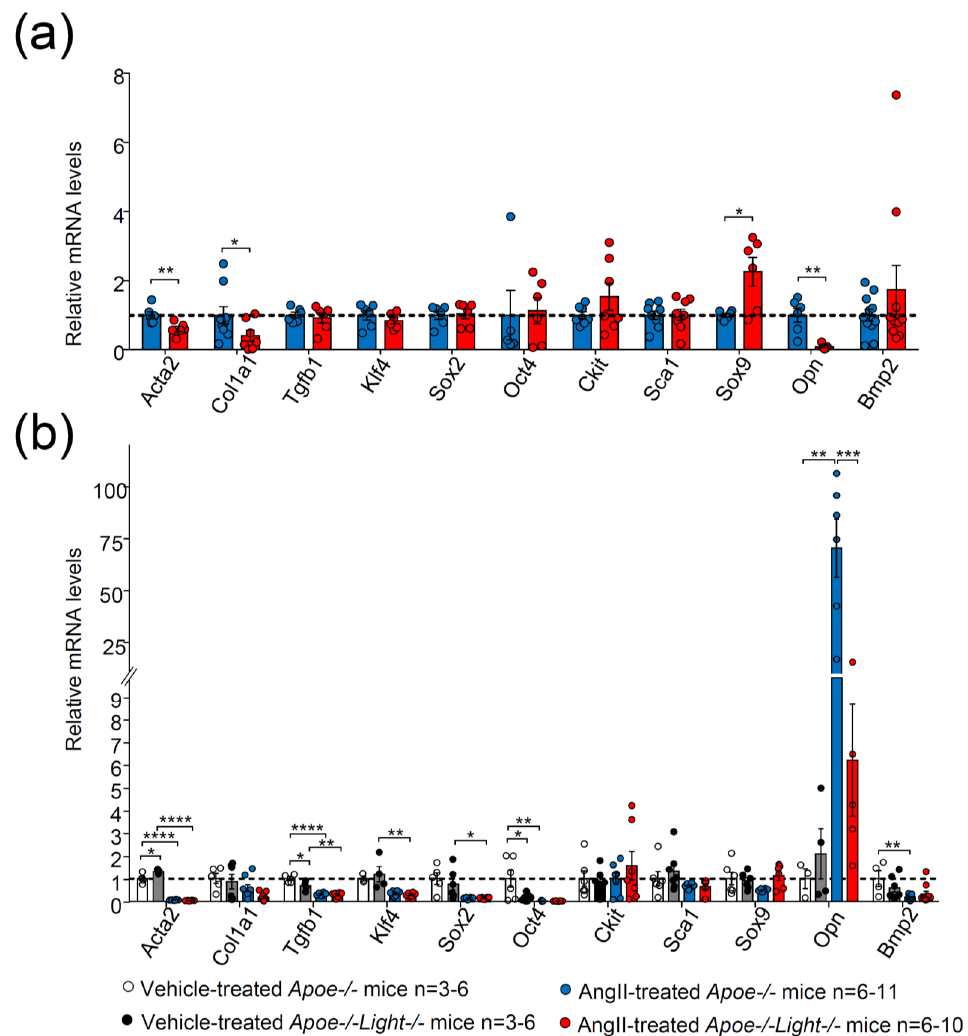
Figure 4. Gene expression analysis in abdominal aortic tissue in vehicle- and AngII–treated Apoe −/− and Apoe −/− Light −/− mice. mRNA levels of Acta2, Col1a1, Tgfb1, Klf4, Sox2, Oct4, Ckit, Sca1, Sox9, Opn , and Bmp2 in ( a ) AngII-treated mice and in ( b ) all four mouse groups. mRNA levels were normalized to Cyclophilin mRNA levels and relativized to ( a ) AngII-treated Apoe −/− mice or to ( b ) vehicle-treated Apoe −/− mice. Statistical analyses were: ( a ) Student’s t-test and Mann–Whitney U test ( Oct4 ) and ( b ) Two-way ANOVA followed by Tukey’s multiple comparison test. Data are mean ± SEM. * p ≤ 0.05, ** p < 0.01 *** p < 0.001, and **** p < 0.0001 .